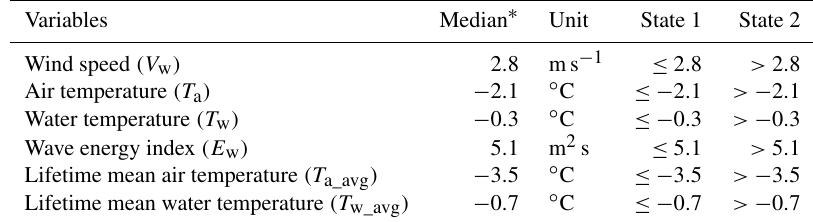
Table 1. Various states of atmospheric and oceanic variables for the Bayesian fracture model. Variables Median ∗ Unit State 1 State 2